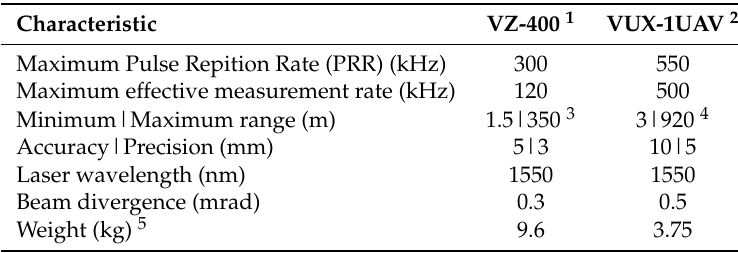
Table 1. VZ-400 and VUX R (cid:13) -1UAV main